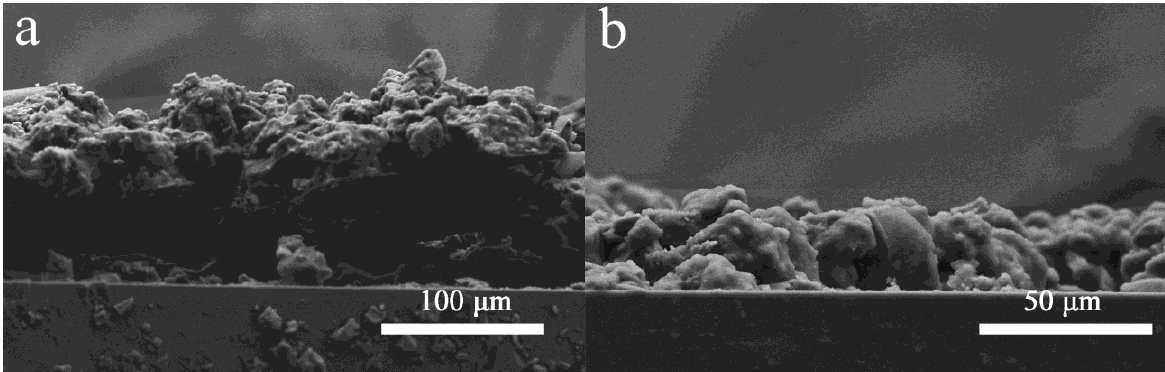
Figure 7. Cross-sectional SEM image of FEP-S coating ( a ) before and ( b ) after sandpaper abrasion at 10 m.